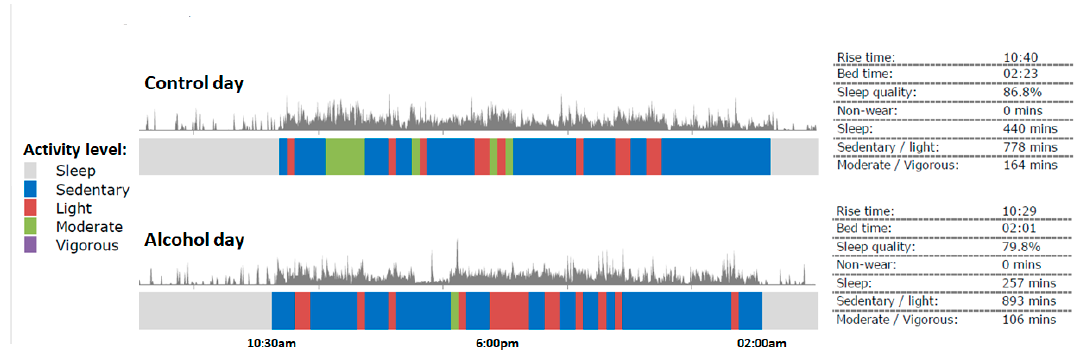
Figure 2. Physical activity levels on the alcohol and control day.